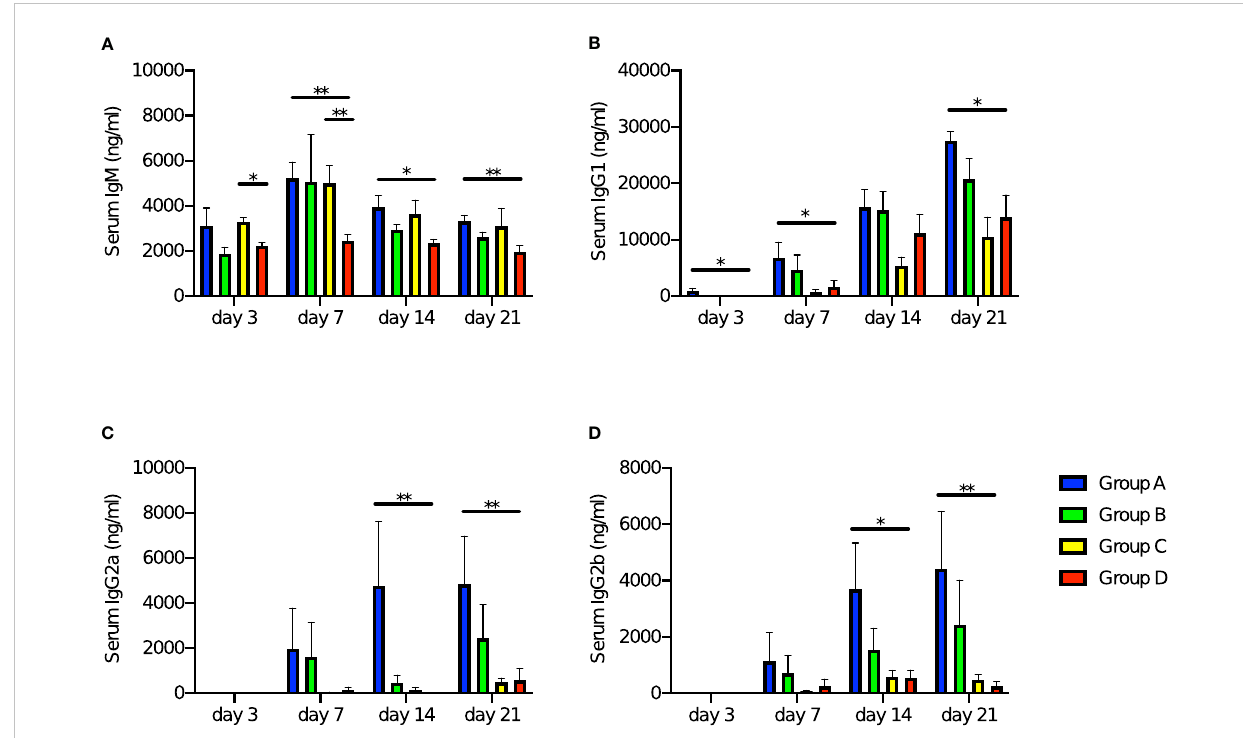
FIGURE 3 Change of levels of anti-PspA antibody in offspring ’ s sera with time after stimulation with rPspA. Four-week-old offspring were subcutaneously stimulated with a single dose of 10 µg of rPspA without any adjuvants. The levels of serum antibodies against PspA were evaluated by ELISA at day 3, day 7, day 14, and day 21 after the stimulation with rPspA. Data is shown as mean with standard error. Blue bar, green bar, yellow bar, and red bar represent Group A (n=9), Group B (n=8), Group C (n=9), and Group D (n=8) respectively. (A) serum IgM, (B) serum IgG1, (C) serum IgG2a, (D) serum IgG2b. Kruskal-Wallis test with Dunn ’ s multiple comparison was performed for comparison between the groups in each day of the blood sampling. *; P <0.05, **; P